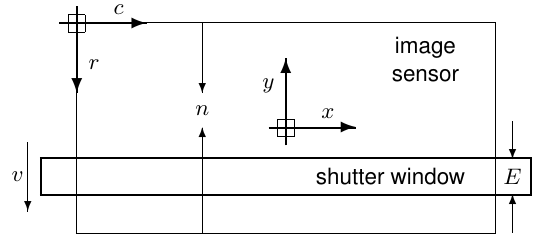
Figure 1: Focal-plane shutter